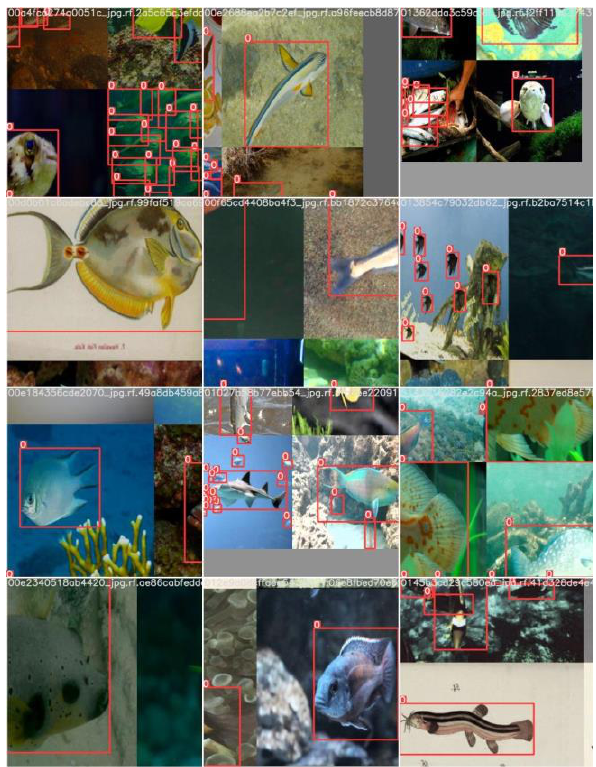
Figure 8 . Training